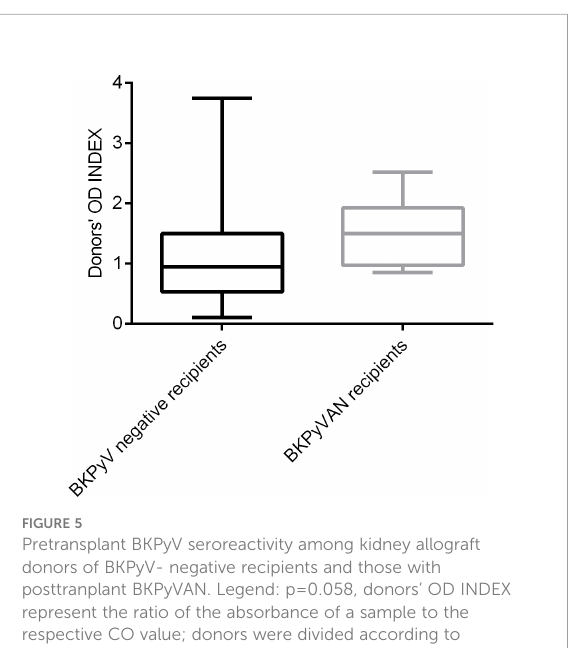
FIGURE 4 Pretransplant BKPyV seroreactivity in kidney allograft donors strati fi ed by posttransplant BKPyV-DNAemia. Legend: ** p=0.0011, * p=0.026. Donors ’ OD INDEX represents the ratio of the absorbance of a sample to the respective CO value; donors were divided according to the posttransplant recipients ’ BKPyV status.